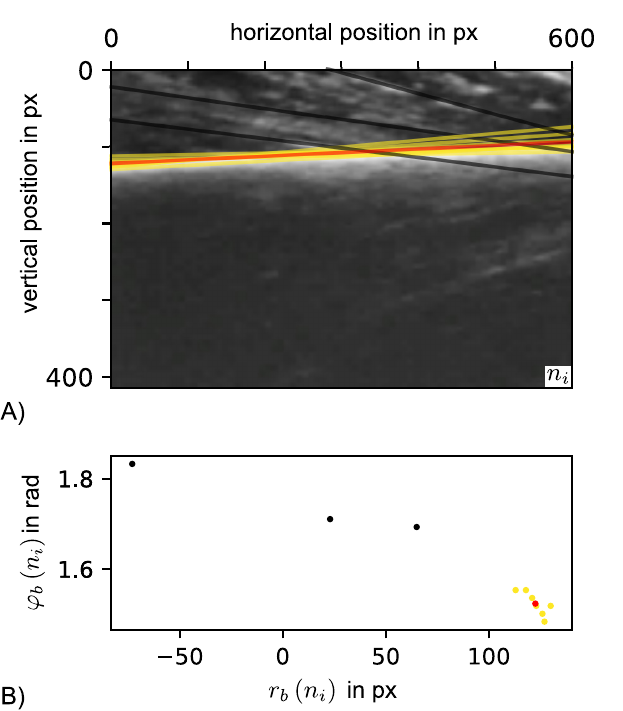
Fig 9. (A) Bone lines detected in a B-mode frame and (B) shown in parameter space. (A) is a frame of the cropped section of a B-mode video. The detected lines have the same color coding as in the scatter plot of the bone line parameter space. (B) The corresponding scatter plot of detected Hough -Lines in their parameter space. The biggest detected cluster is shown in yellow and its mean is shown in red. All other data points are black.